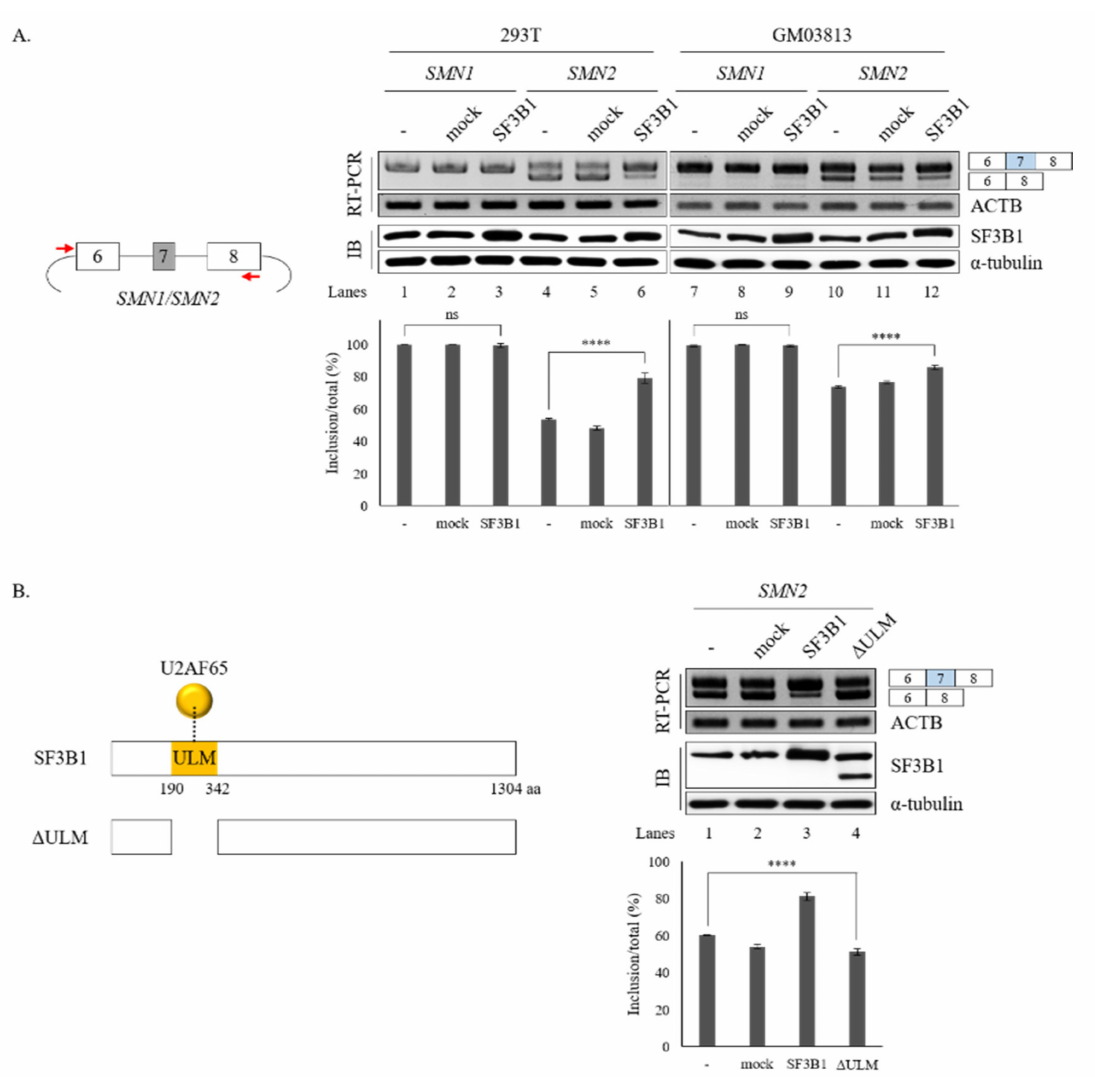
Figure 5. ULM is required for SF3B1 function in SMN exon 7 splicing. ( A ) (Left) Schematic representation of SMN1 or SMN2 minigenes. (Right) RT-PCR analysis of SMN1 or SMN2 pre-mRNA within minigenes in SF3B1-overexpressed cells or control cells transfected with empty plasmids using ACTB as a control. Expression levels of SF3B1 protein are shown with immunoblotting with α -tubulin as a control. Statistical analysis results of RT-PCR are shown with p -values: **** p < 0.0001; *** p < 0.001; ** p < 0.01; and * p < 0.05. ( B ) (Left) Schematic representation of ∆ ULM mutant SF3B1 protein. (Right) RT-PCR analysis of SMN2 pre-mRNA in cells overexpressed with wild-type and ∆ ULM mutant SF3B1. Quantitation results are